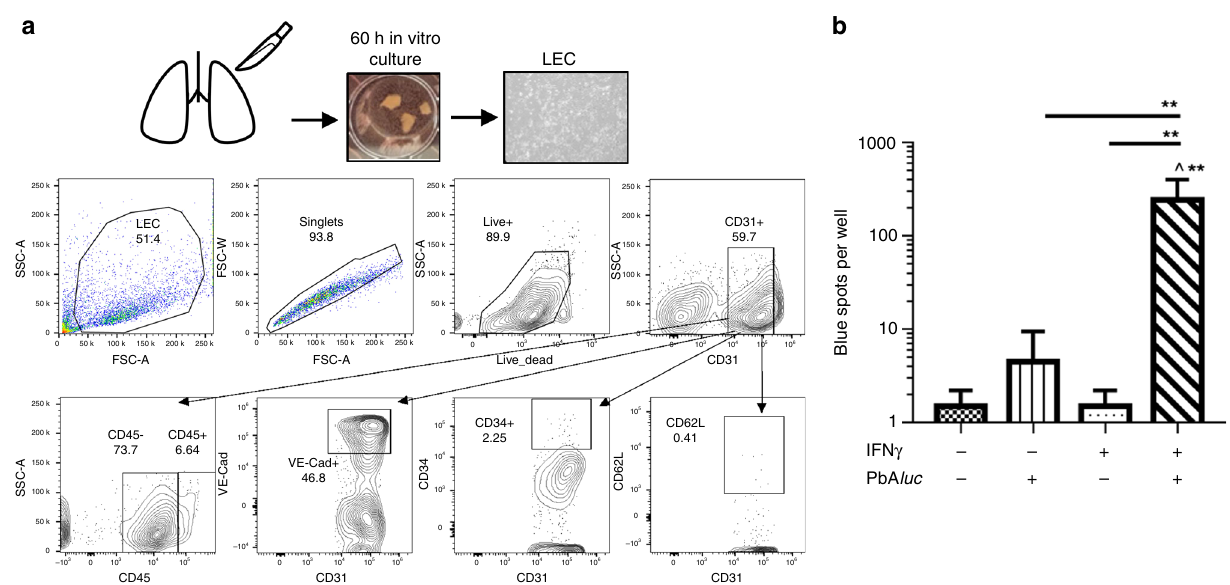
Fig. 8 IFN γ -stimulated lung endothelial cells (LEC) cross-present in vitro PbA luc antigen to reporter cells. a LEC primary culture protocol. Mouse lungs were excised and cut into 1 × 1 × 1 mm 3 pieces and placed in a 6-well plate for 60 h. The histograms are representative of two independent culture experiments and show characterization of the endothelial cells by fl ow cytometry (staining for CD45, CD31, VE-Cadherin (CD144), CD34 and CD62L (L-selectin)). Almost 80% of the cultured cells were CD45 − CD31 + endothelial cells. b LEC seeded in triplicate wells of a 48-well plate were stimulated or not with 10 ng/ml IFN- γ for 24 h and then incubated or not with 5 × 10 5 thawed PbA luc -matured iRBCs for a further 24 h. The wells were washed and co-cultured with LR-BSL8.4a reporter cells overnight stained for β -gal. The data represent the mean ± SD; ** p < 0.01, by ANOVA with Bonferroni ’ s post-test. ^Statistically signi fi cant compared to the fi rst well (negative control) ( p <